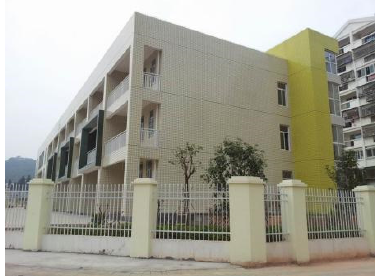
Figure 3. Elevation of the building.